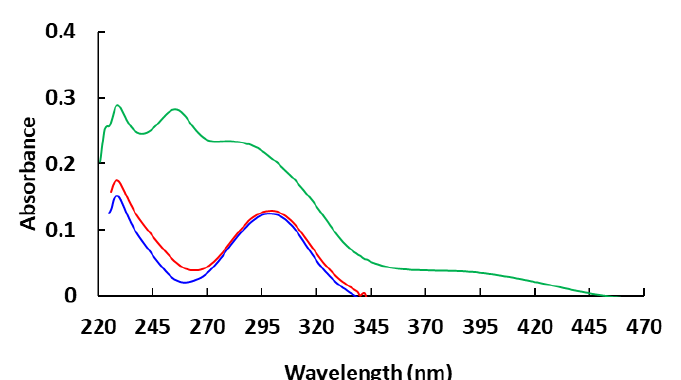
Figure 1. The experimental UV – Vis absorption spectra of the compounds in DCM solutions (10 − 5 mol/L).